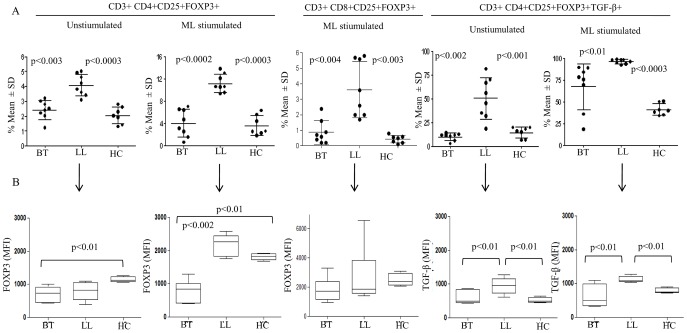
CD4+CD25+FOXP3+ iTreg cells are increased in vitro in PBMC of lepromatous patients and show intracellular TGF-β.
A. Scatter diagram gives Mean% ± SD of FOXP3 cells from 48 hr PBMC cultures as given in Figure 4 and Materials and Methods. 10 each of lepromatous (LL), tuberculoid leprosy (BT) and 7 of healthy household contacts (HC) were investigated. CD3+, CD4+CD25+ cells showed significant increase in FOXP3 (iTregs) in lepromatous patients as compared to other clinical groups. B. This was further confirmed by mean fluorescence intensity (MFI) in all except unstimulated cultures for FOXP3 marker. Antigen stimulated PBMC showed increase in mean percentage as well as higher MFI with the lepromatous subjects showing higher values as compared to the other 2 groups. Intracellular TGF-β was associated with iTregs with significant increase in percentage of cells as well as in MFI in the lepromatous group. CD8+ lineage of cells also showed increase in FOXP3+ cells with negligible to low TGF-β (Figure 4). Abbreviations and p values as given in Figure 2.